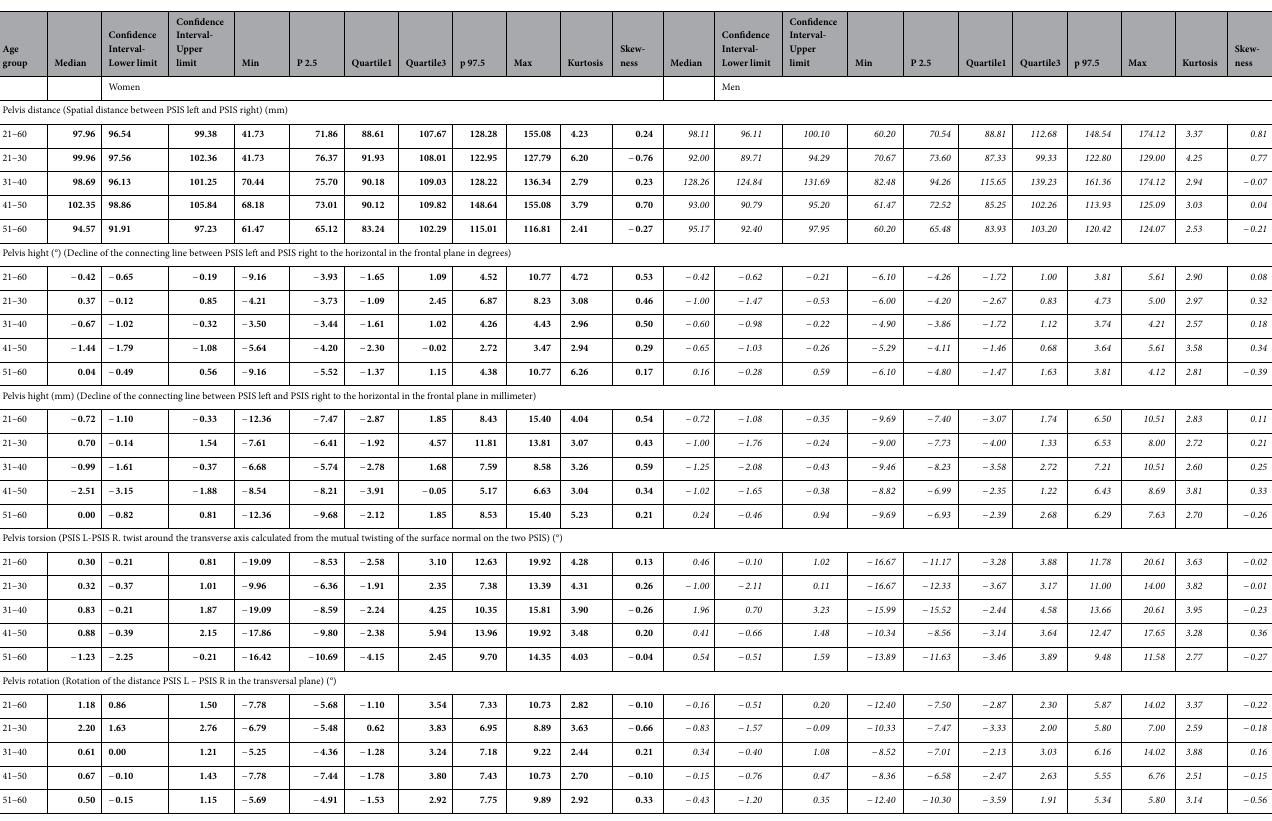
Table 4. Median, confidence interval (lower/upper limit), minimum (Min), percentile (P) 2.5, quartiles 1 and 3, percentile 97.5, maximum (Max), kurtosis and skewness of the pelvis parameters. All data are color-coded by sex (women = Bold; men = italic). For each sex, four age groups (21–30, 31–40, 41–50,51–60) and all age groups are shown